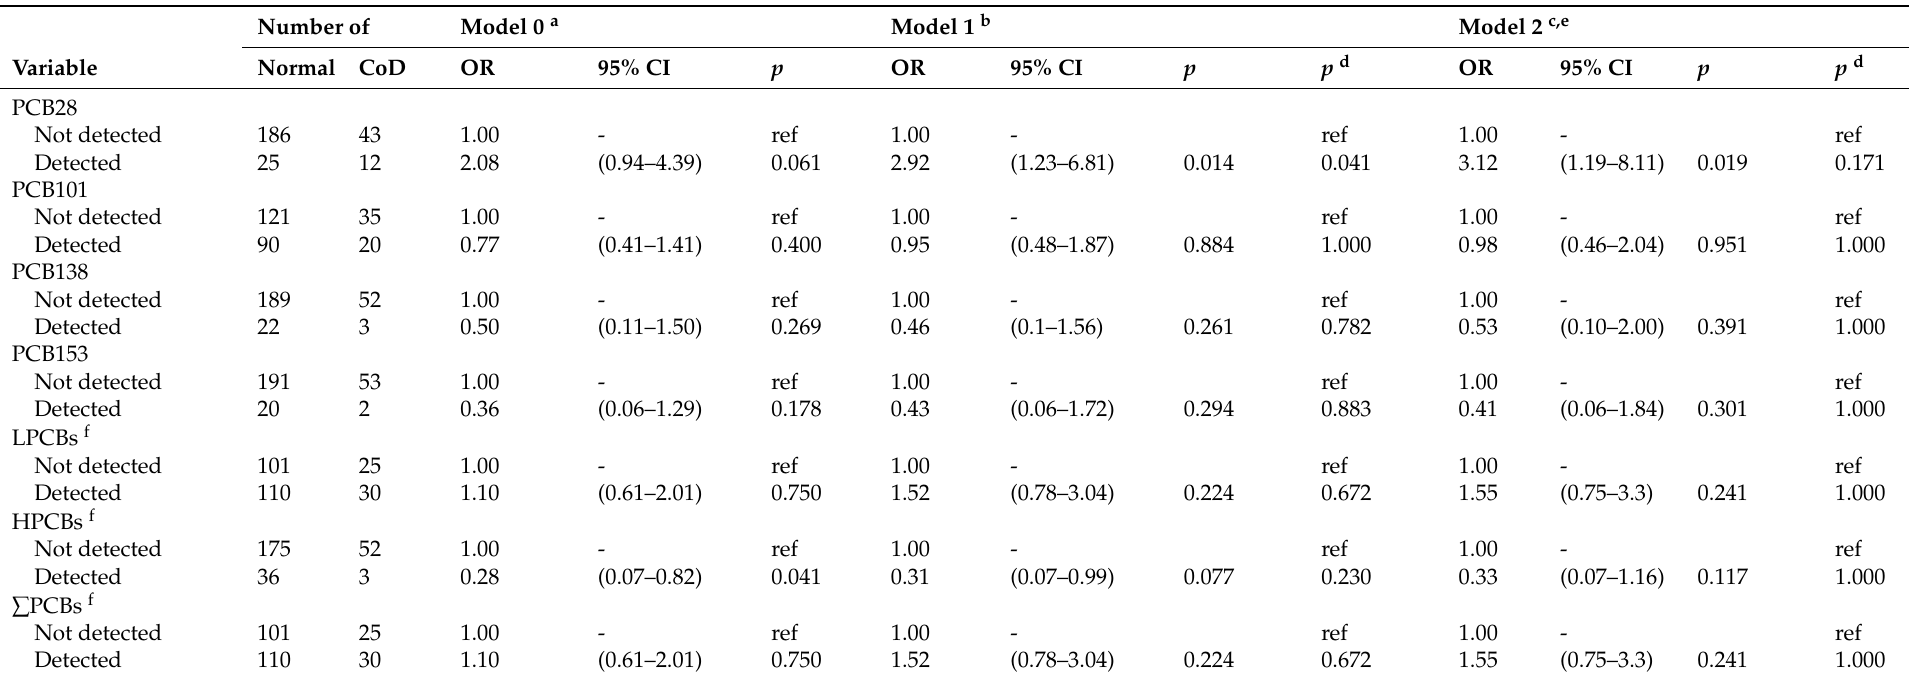
Table 3. Association of Plasma PCB burden with cognitive impairment (N =